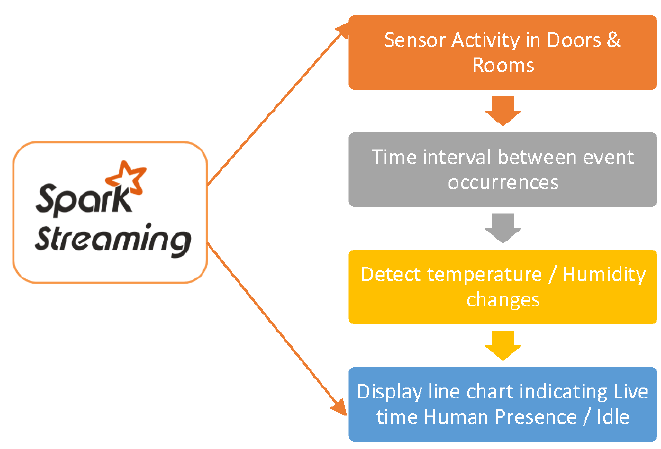
Figure 10. Spark Stream processing pipeline for activity patterns.